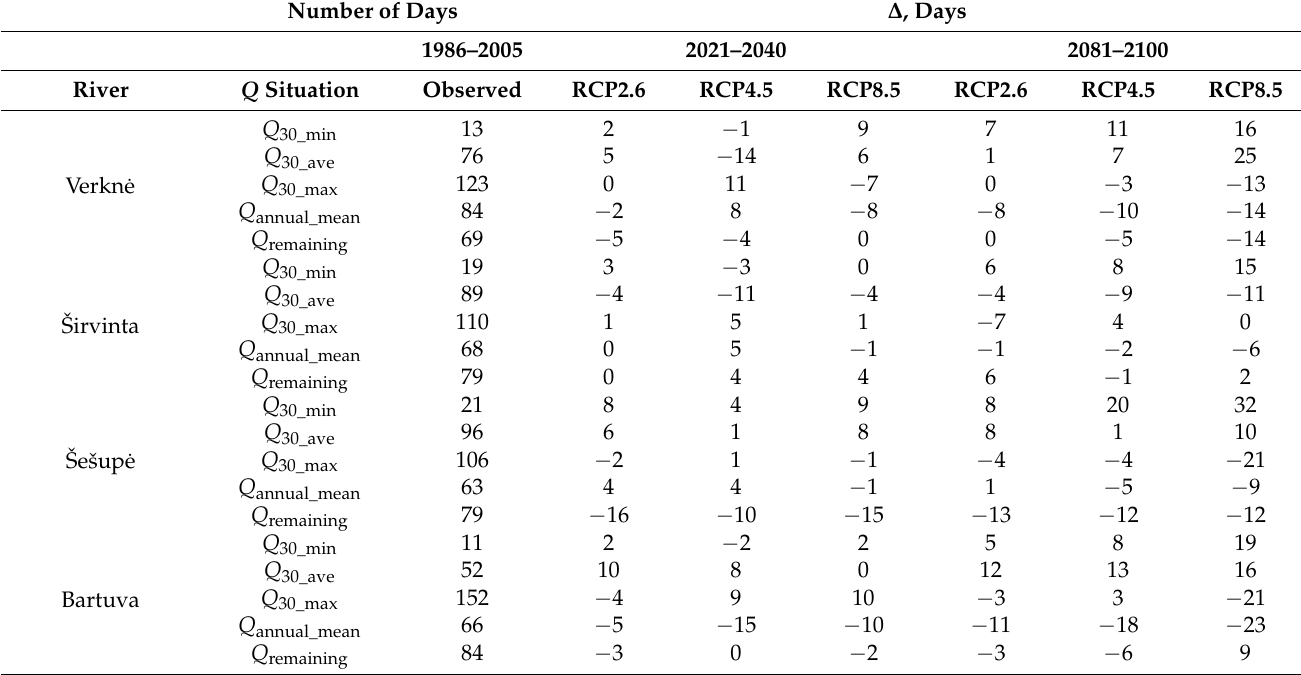
Table 4. Changes in the average number of days of target discharge in the Verkn˙e, Širvinta, Šešup˙e, and Bartuva rivers according to different RCP scenarios for the periods of 2021–2040 and 2081–2100 compared to the reference period